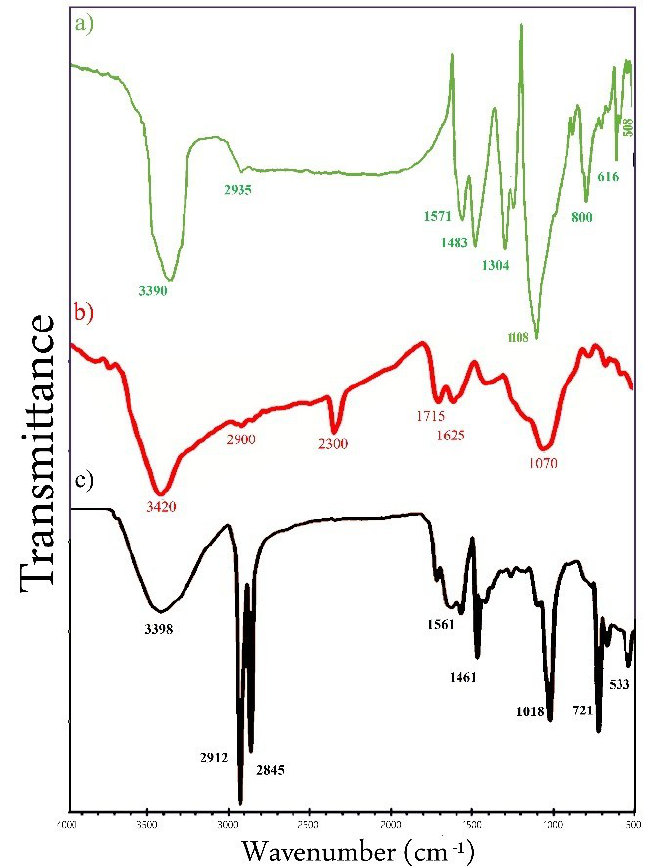
Figure 4. FTIR-analysis for ( a ) ZnO-MWCNT, ( b ) GO, and ( c ) ZnO. Table 1. Show the results of FTIR for nano products prepared